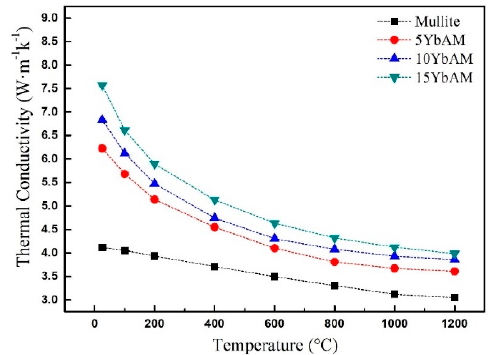
Figure 8. Thermal conductivity of samples as a function of temperature.